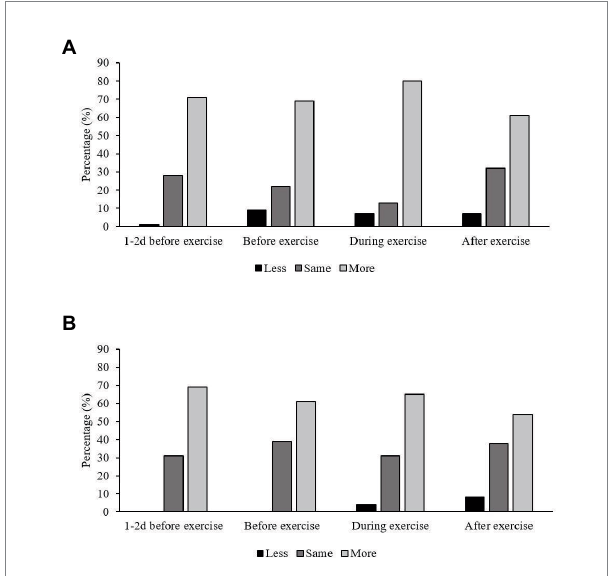
FIGURE 2 Bar chart showing endurance athletes with ( n = 137) and without ( n = 64) exercise-associated gastrointestinal symptoms (Ex-GIS) and their intended practices for consuming less, the same or more carbohydrates around various exercise times. Intention to consume carbohydrates is indicated by a Likert scale: 1, intention to consume less; 2, intention to consume the same; 3, intention to consume more. Timing defined as: 1–2 d before exercise = 1–2 days before an event ≥ 90 min; Before exercise = in last meal or snack before endurance training or an event ≥ 90 min; During exercise = during endurance training or an event ≥ 60 min; After exercise = within 30 min after endurance exercise when there is ≤ 8 h between sessions; (A) athletes with reported Ex-GIS; (B) , athletes without reported